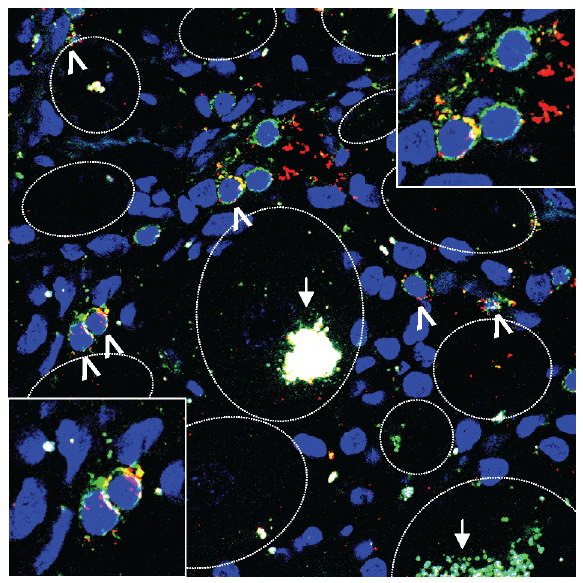
Figure 5. HSV-1 epitope-specific CD8 T-cells are localized close to sensory neuron cell bodies in the contralateral human TG. Representative image of the TG tissue of donor TG2 stained with DAPI (blue), anti-CD8 (green) and tetramers (red) that consisted of both the synthetic HSV-1 peptides ICP0 642–651 and ICP8 1096–1105 conjugated to HLA-A*0201. Inserts, lower left and upper right corner, are enlarge- ments of areas containing tetramer-positive CD8 T-cells. The white arrows and arrowheads signify autofluorescent granules containing lipofuscin and tetramer-positive CD8 T-cells, respectively. Neuron outlines are marked with a white dashed line. Magnification was 6